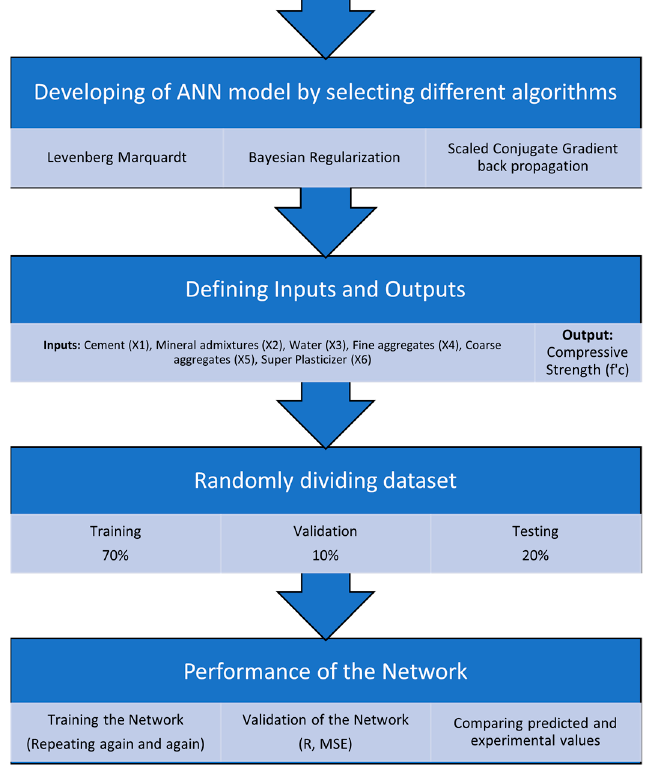
Figure 7. Methodology of research work.